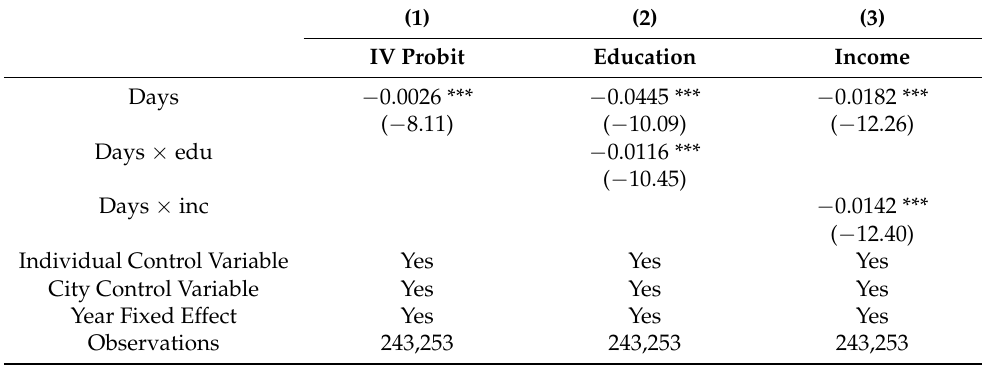
Table 4. Robustness